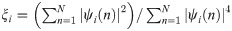
Spectral analysis of Google matrix for SIGNOR database.(a, b) Complex spectrum {λi}i = 0,…,N−1 of Google matrices G (a) and G* (b) at α = 0.85, computed for SIGNOR molecular interaction database. Colors give the inverse participation ratio ξi from ξi = 1 (black) to ξi = 150 (bright yellow). (c, d) Inverse participation ratio ξi=(∑n=1N|ψi(n)|2)/∑n=1N|ψi(n)|4 of the ith eigenvector as a function of Re (λi) for Google matrices G (c) and G* (d). Colors give in logarithmic scale i indexes of eigenvalues ranked by decreasing modulus; from i = 1 (black) to i = N = 2432 (bright yellow). Quasi-uniform picture of the spectrum reflects inexistence of weak protein node communities in the SIGNOR network.